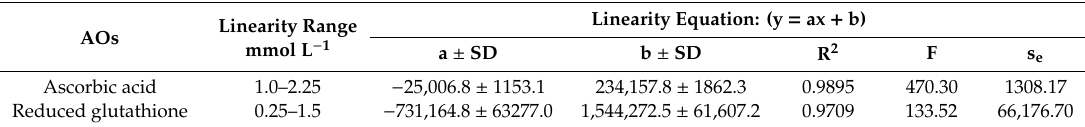
Table 3. Linear regression parameters for the detection conditions of AOs by DPPH-R quench at 517 nm. Concentration of DPPH-R was 0.5